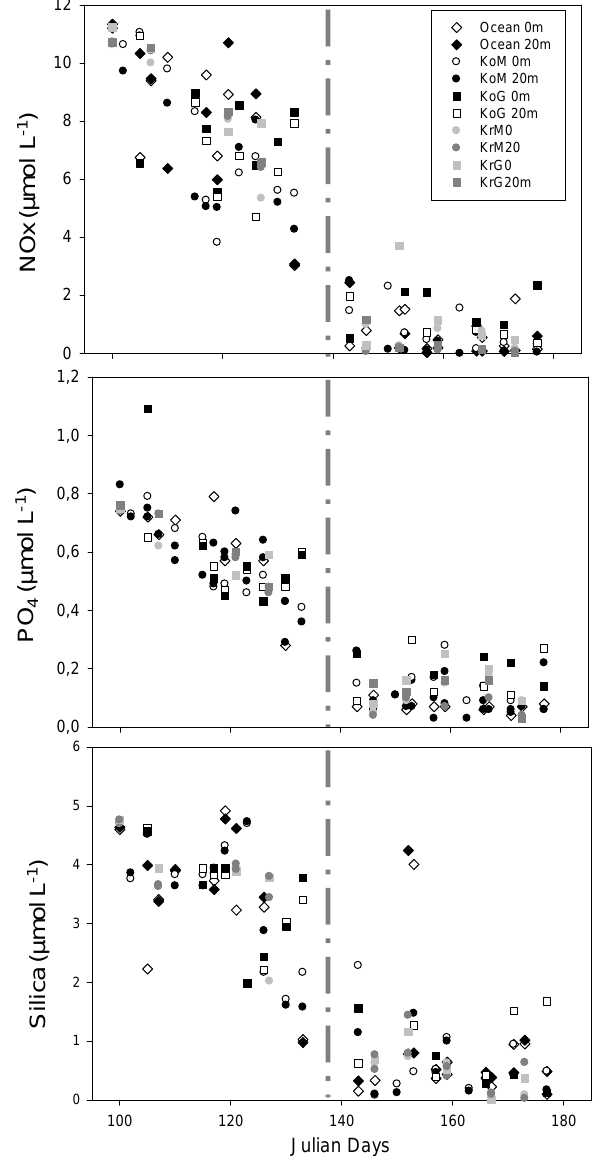
Fig. 4. Nitrate, phosphate and silica concentrations from the five Figure 4. Nitrate, phosphate and silica concentrations from the five sampling locations2 sampling locations collected over time in Julian days. The dotted collected over time in Julian days. The dotted line separates the 2008 (left panel) from the3 line separates the 2008 (left panel) from the 2007 (right panel) sam- pling 2007 (right panel) sampling period.4